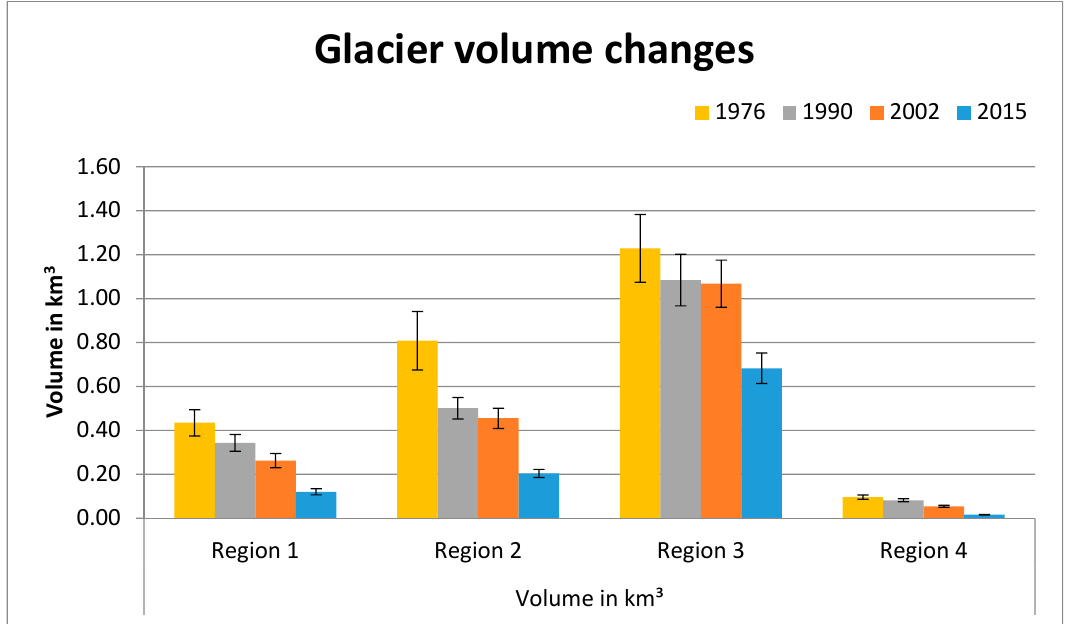
Figure 5. Absolute average volume changes of the detected glaciers in Sub-Regions 1–4 between 1976 and 2015.